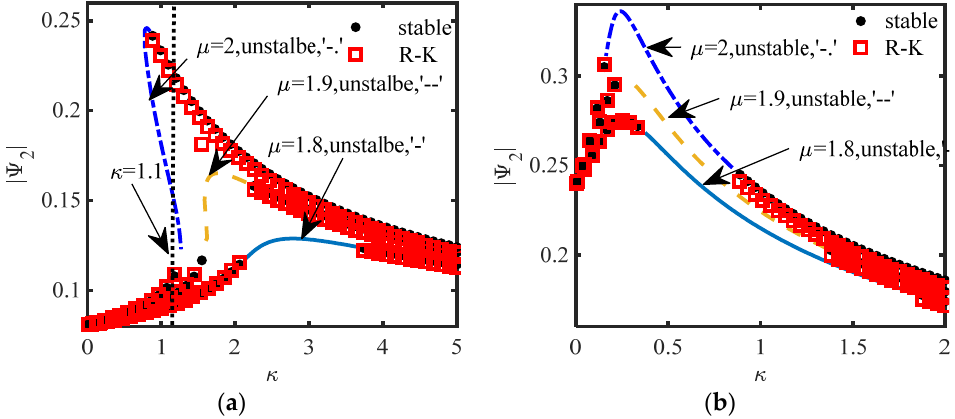
Sensors 2022 , 22 , x FOR PEER REVIEW Figure 11. The different stabilities of the equilibrium points (S.1): ( a ) m 2 = 0.3; ( b ) m 2 = 4. Figure 11. The different stabilities of the equilibrium points (S.1): ( a ) m